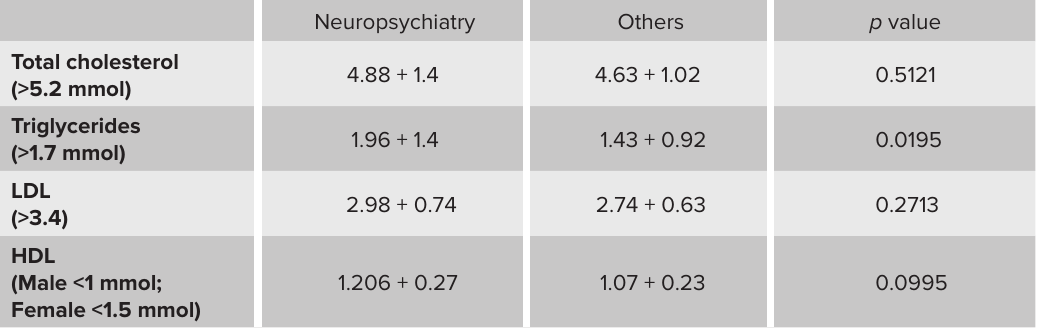
Table 5: The Relationship Between Neuropsychiatric Manifestations and Dyslipidemia. Neuropsychiatry